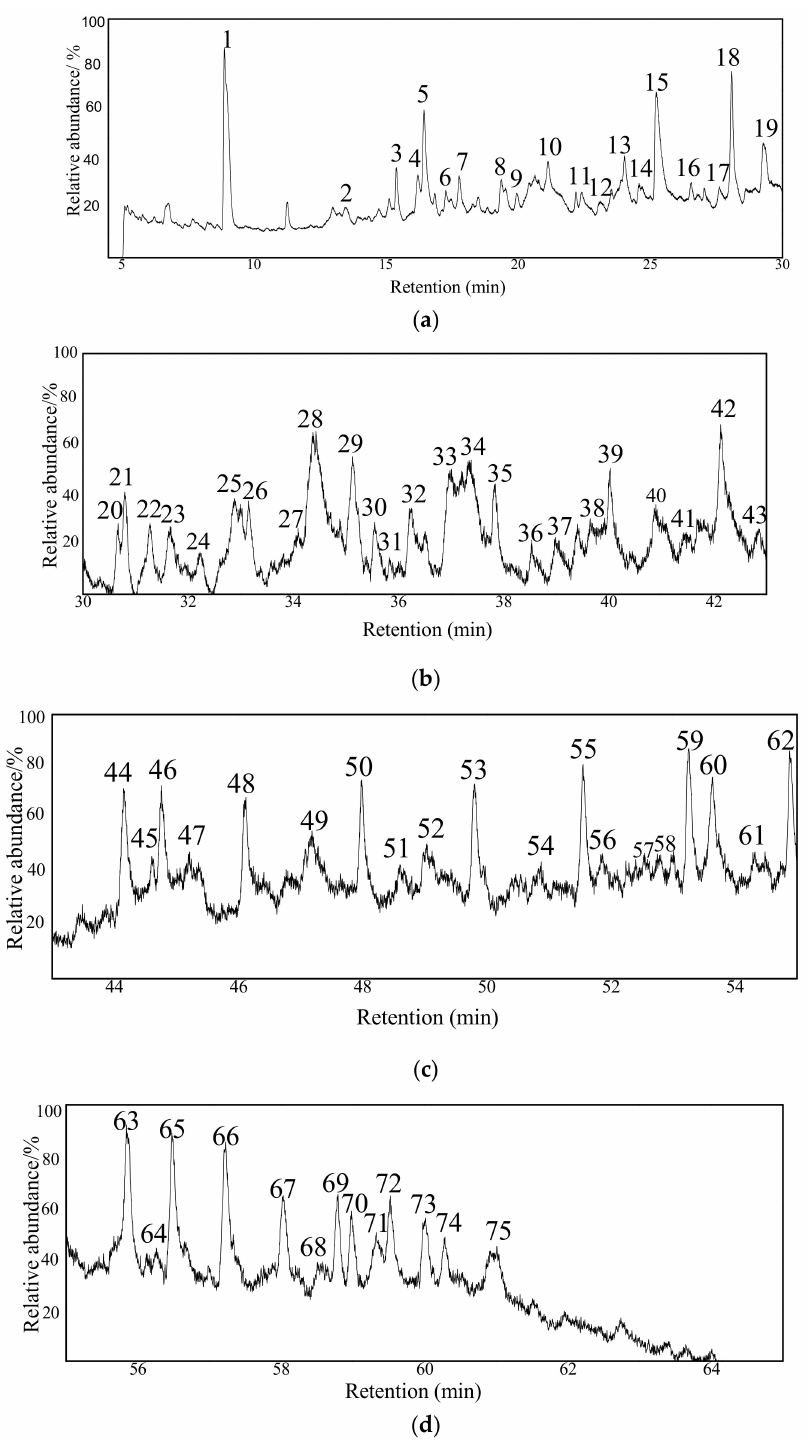
Figure 5. TIC for the extract obtained by the MAE process. ( a ) TIC of 5–30 min; ( b ) TIC of 30–43 min; ( c ) TIC of 43–55 min; ( d ) TIC of 55–65